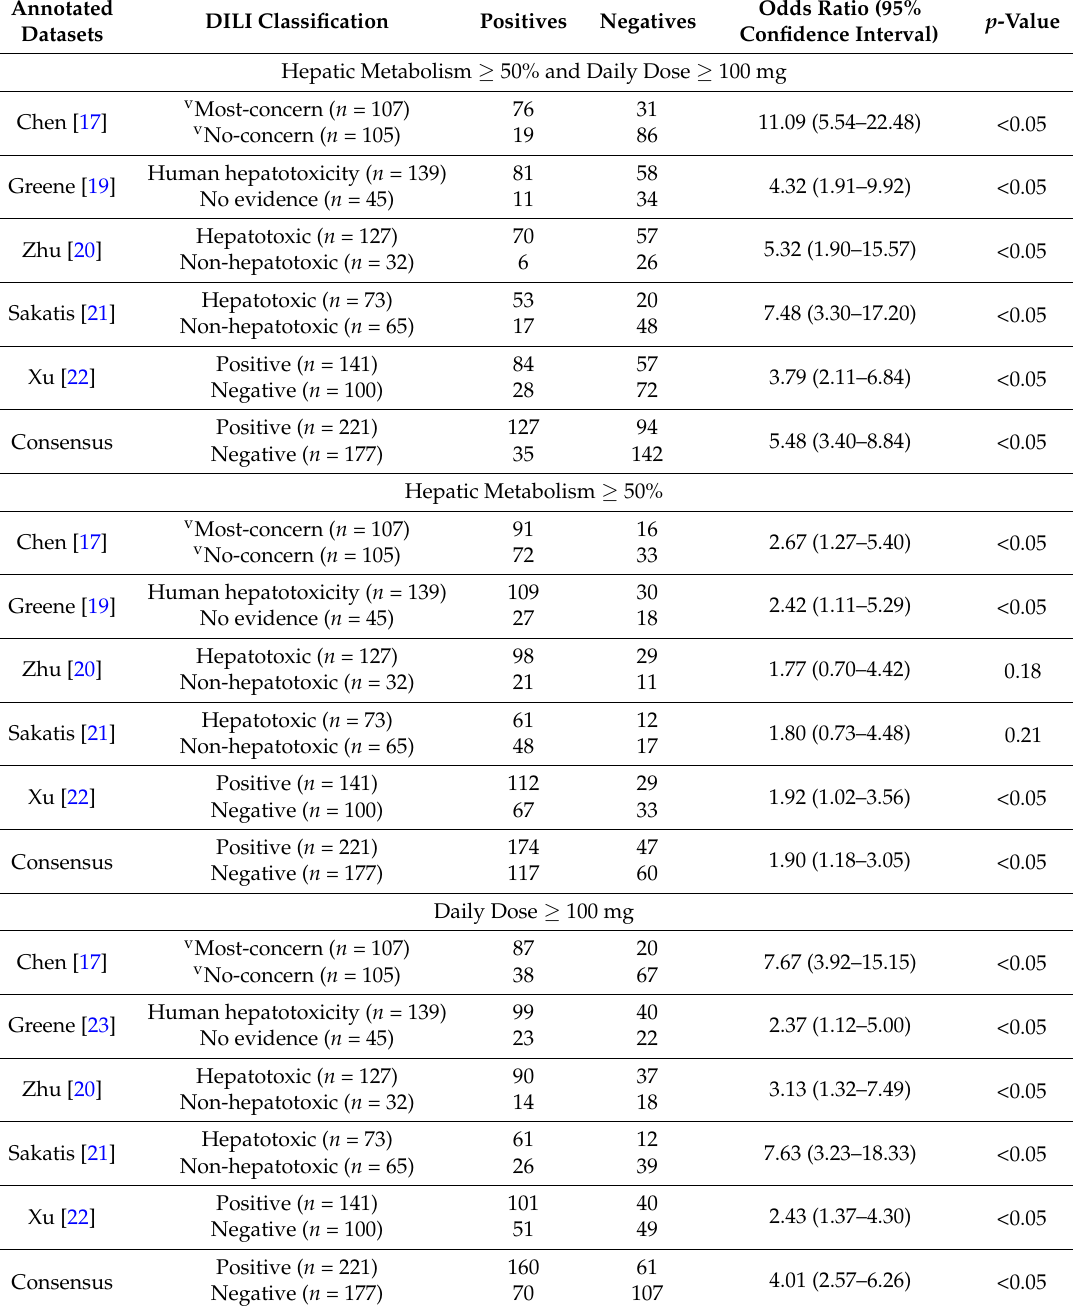
Table 2. The assessment of the relationship between DILI risk, the extent of metabolism, and daily dose.